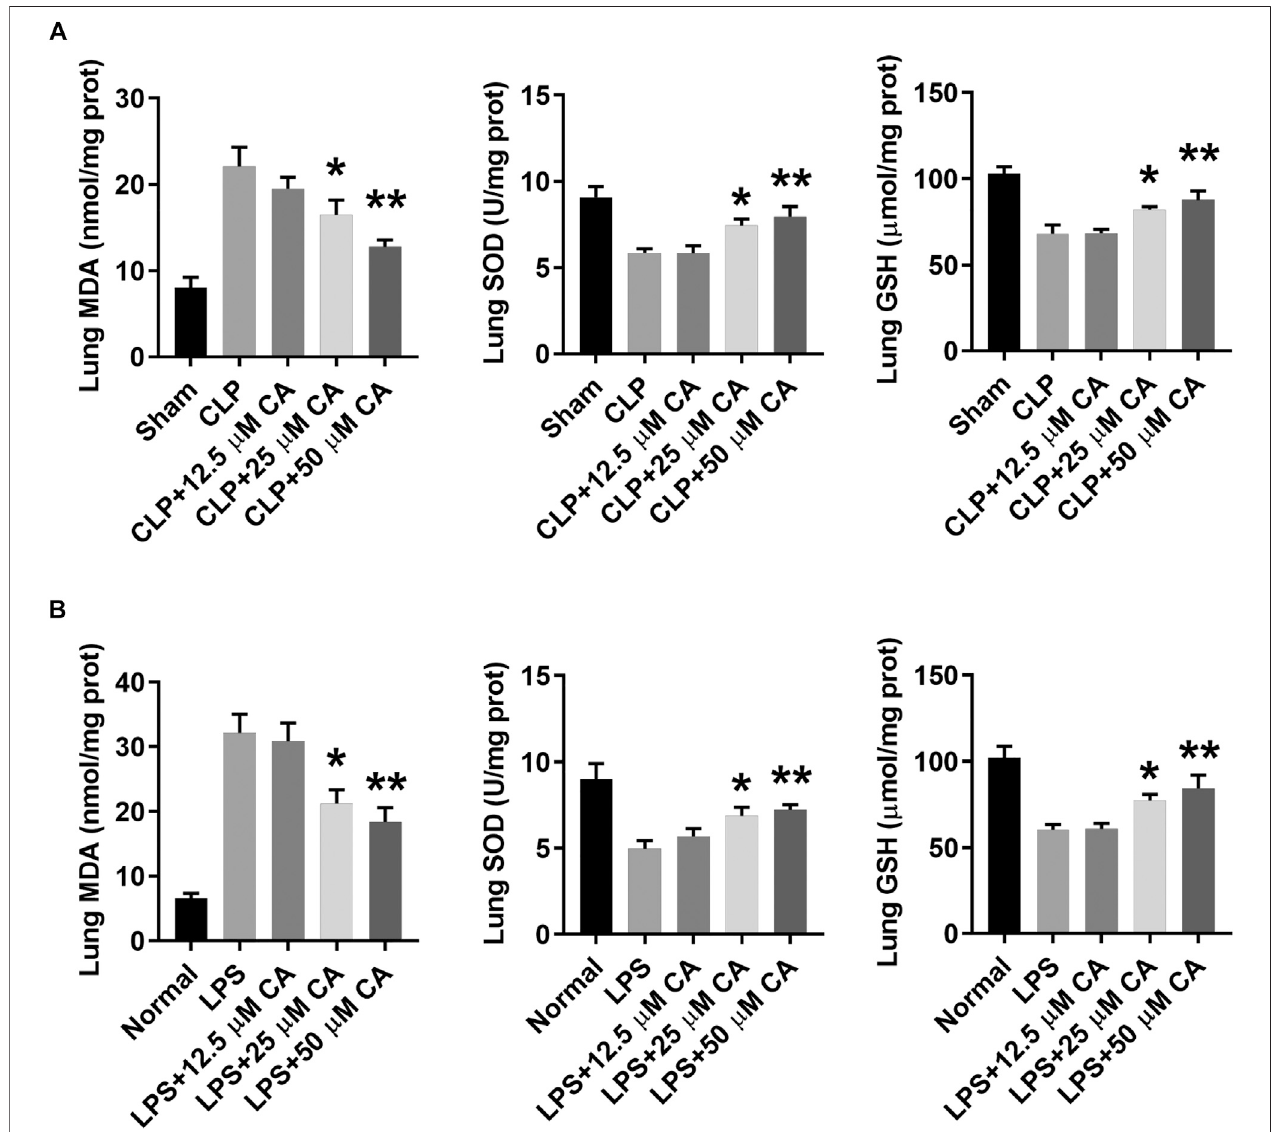
FIGURE 5 | Calycosin inhibits oxidative stress in lung tissue. The ligated or LPS-injected mice were treated with calycosin by gavage at 0 and 6 h. After 12 h, malondialdehyde (MDA), superoxide dismutase (SOD),and glutathione(GSH) levels inlungtissues weredeterminedbycommercial kits.Dataarepresented asmeans ± SEM. * p < 0.05; ** p < 0.01 vs. the CLP or LPS group.